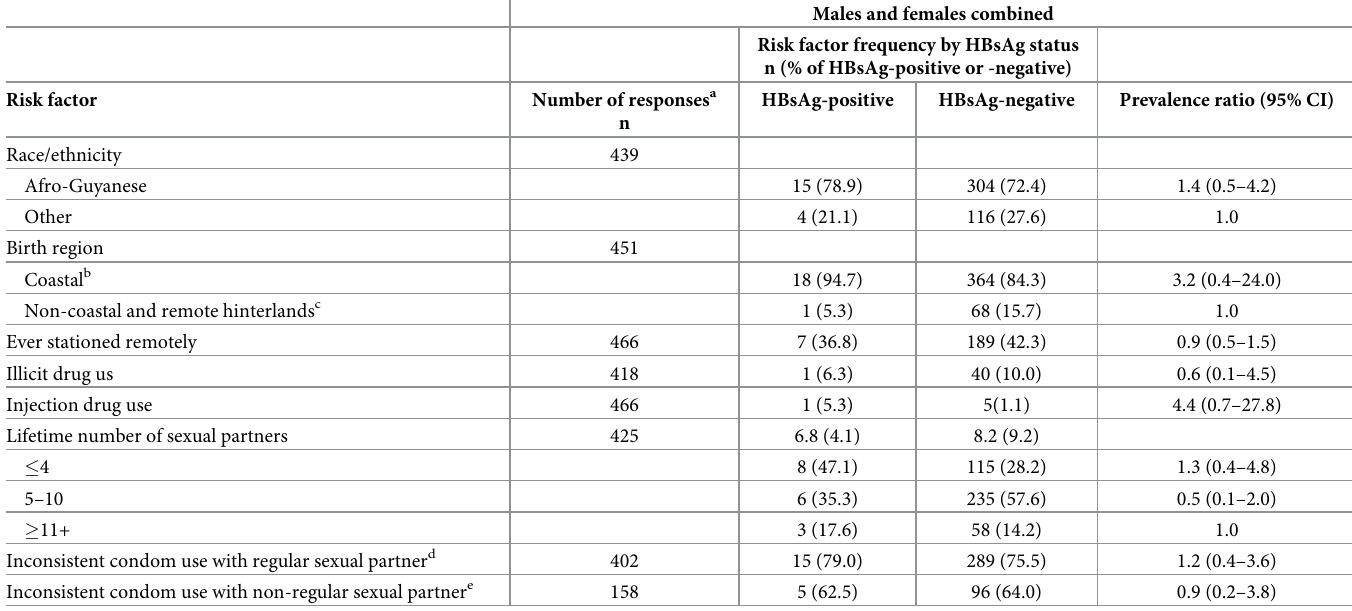
Table 2. Frequency of self-reported demographic and behavioral risk factors by hepatitis B virus infection status among military forces, 2011 Guyana Defence Force Seroprevalence and Behavioral Epidemiology Risk Survey for HIV and sexually transmitted